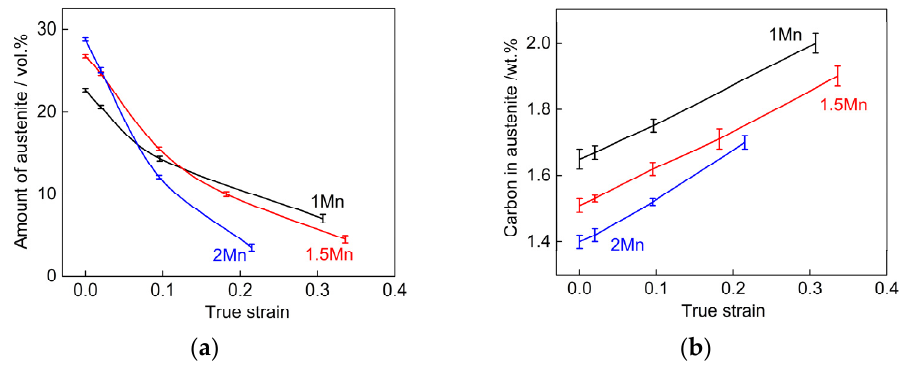
Figure 8. ( a ) The change of austenite fraction and ( b ) carbon content in austenite as a function of true strain, obtained from XRD results. Table 5. The change in the dislocation density and fraction in retained austenite at different strains, as obtained by EBSD. (Unit of dislocation density: 10 15 m − 2 ; fraction of retained austenite: vol.%) D γ , D α , and V γ represent density of austenite, density of ferrite, and fraction of retained austenite. Strain (Engineering